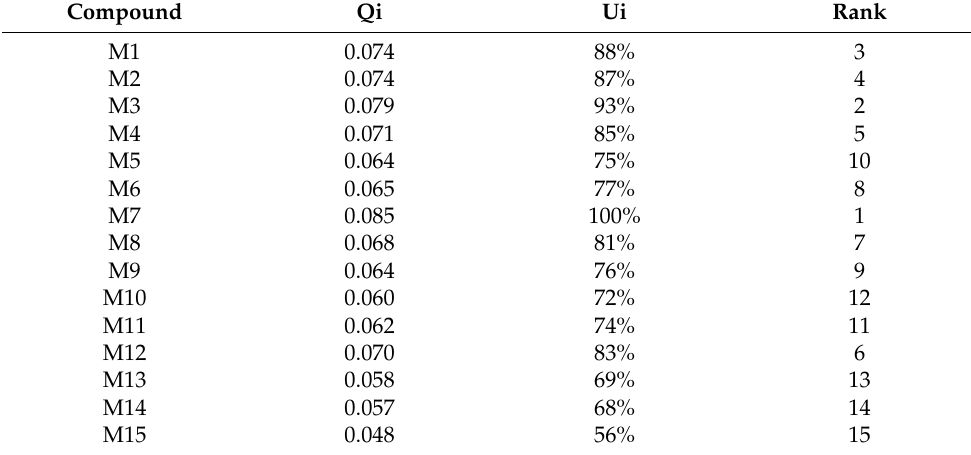
Table 19. COPRAS